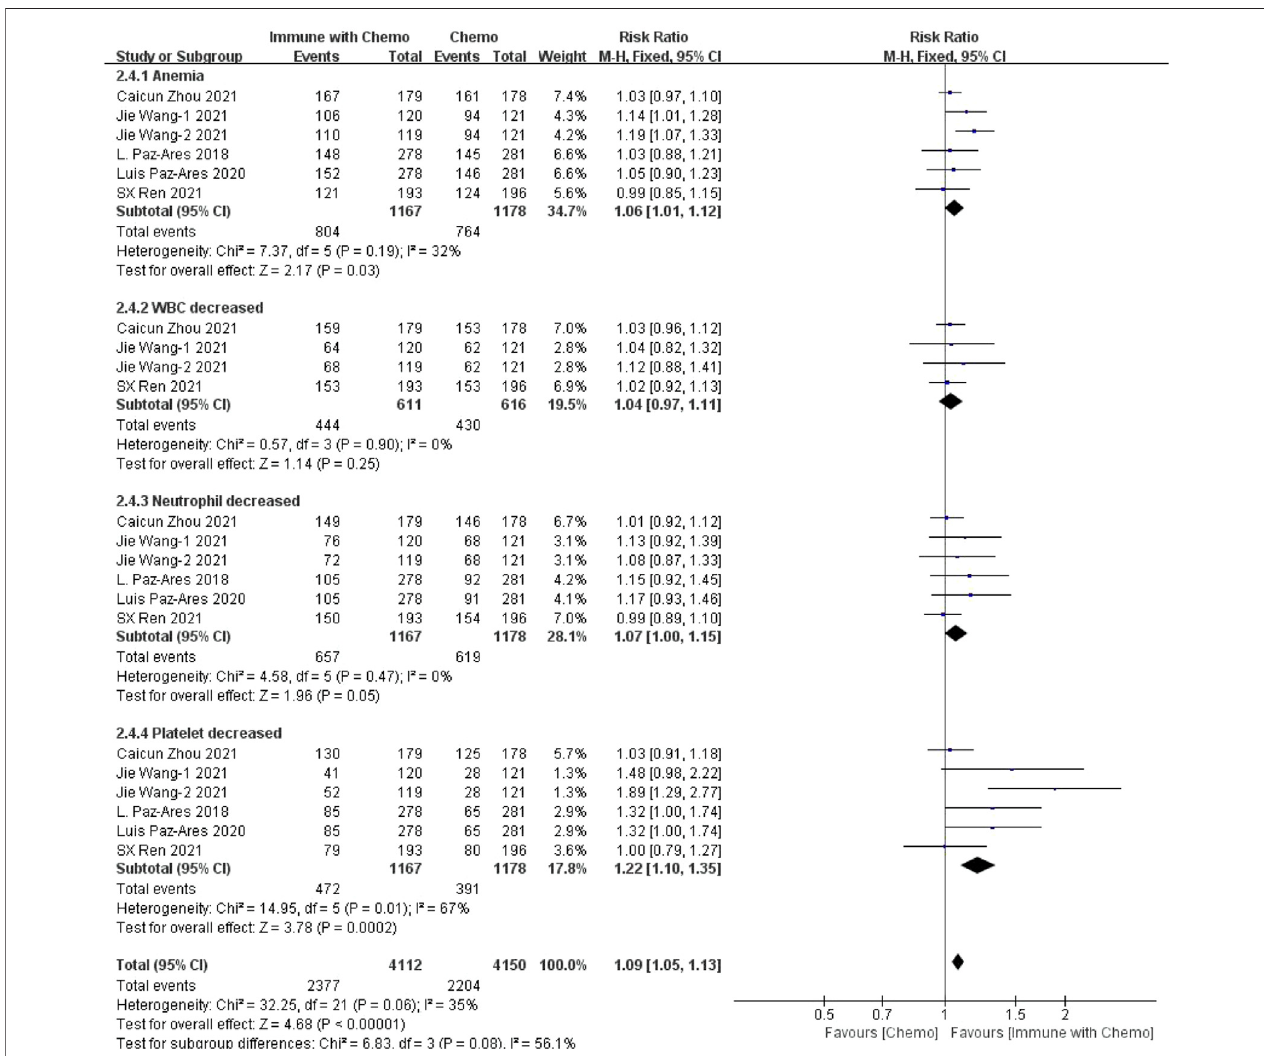
FIGURE 3 | Meta-analysis results of adverse reactions of any grade in hematological toxicity between the chemo with immune group and chemo group.